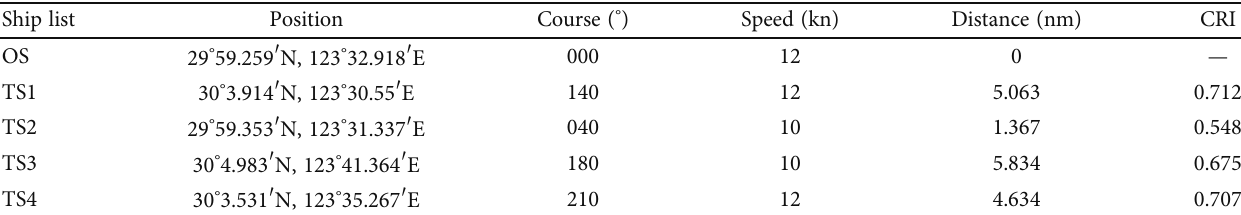
(d) The relative distance between OS and TS Figure 15: The simulation results under crossing encounter situation. Table 9: Initial information of the ships for multiship